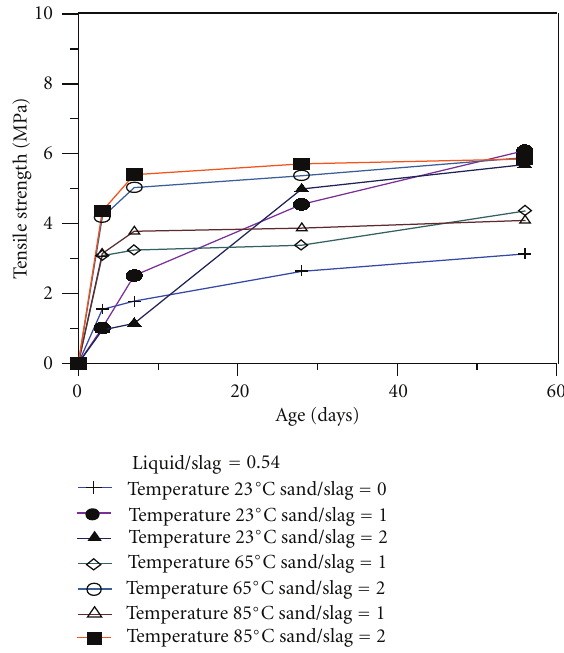
Figure 6: Tensile strength of AAS mortars ( L/S = 0 . 54).